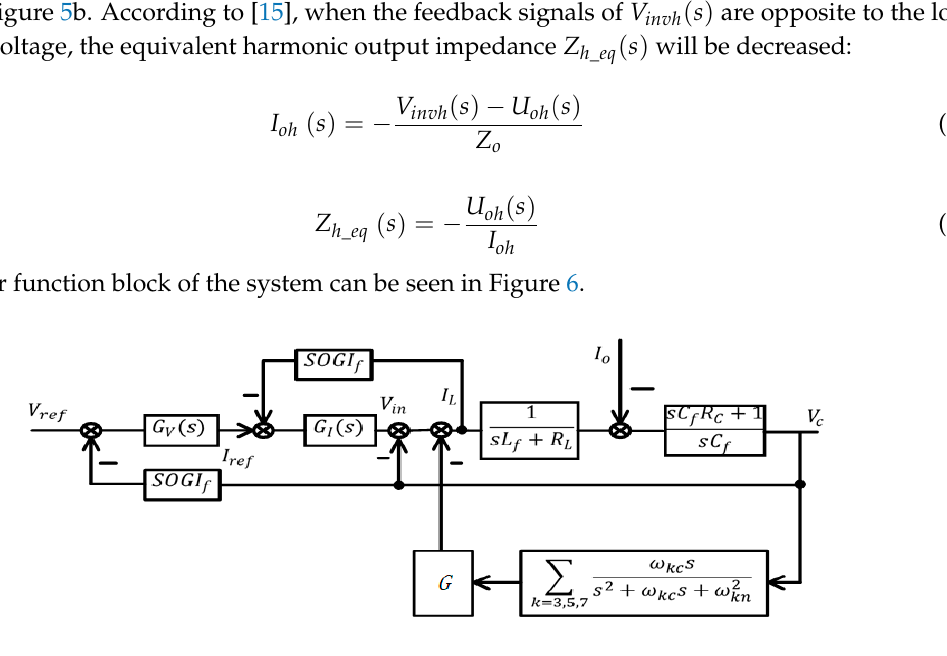
Figure 6. The transfer function block of the voltage feedback system.